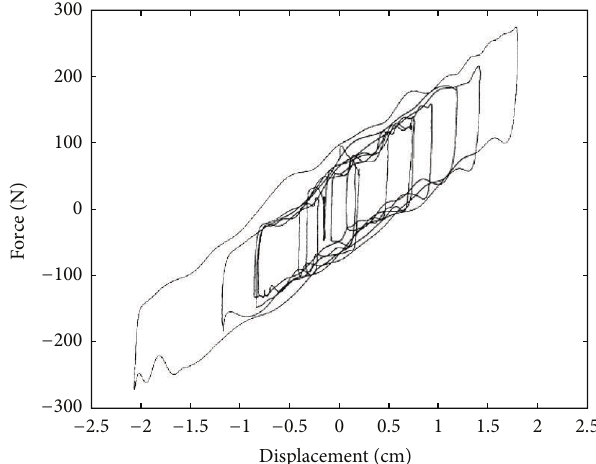
Figure 14: Force-displacement diagram—industrial truck seat exposed to random excitation